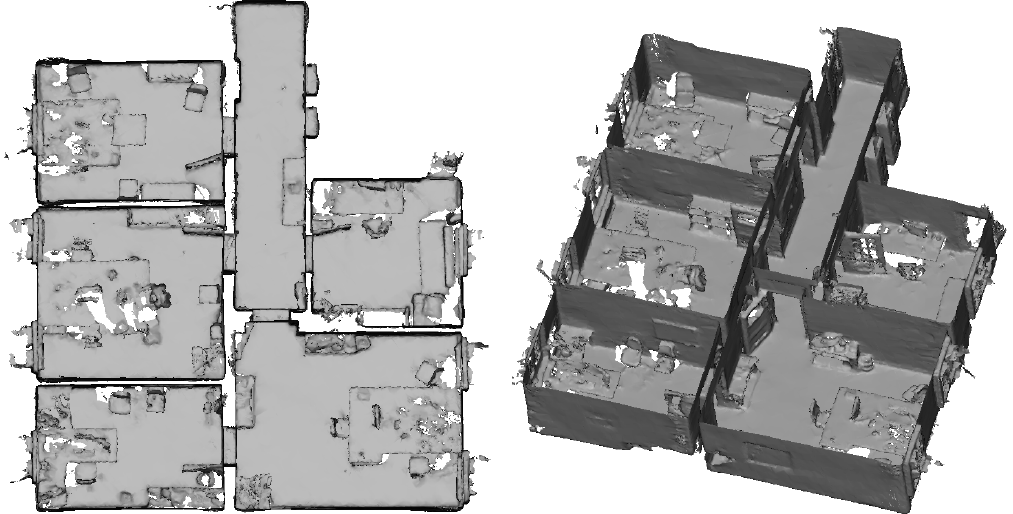
Figure 16. Triangle mesh of an indoor office environment captured by the HoloLens. The ceiling is removed for better